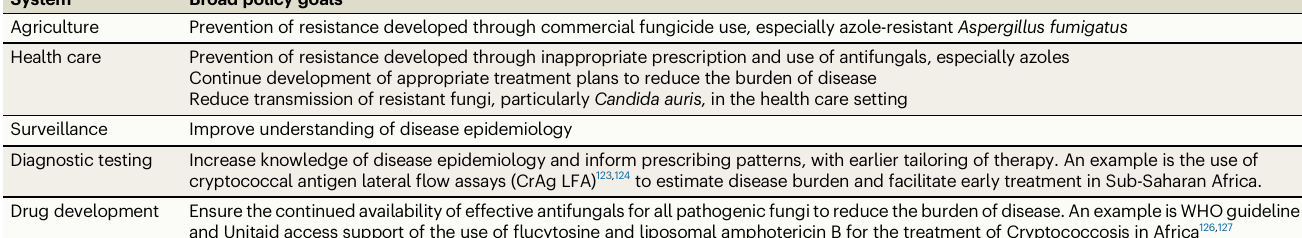
Table 1 | Systems that have an impact on antifungal drug resistance System Broad policy goals Agriculture Health care Surveillance Diagnostic